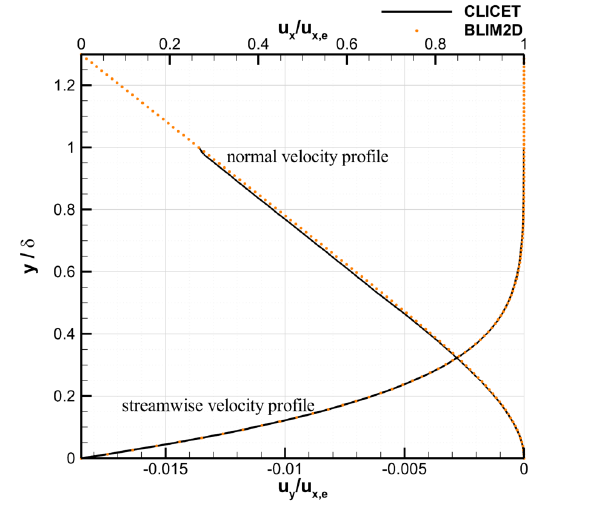
Figure 2. Velocity profiles for CLICET (reference) and BLIM2D, at x / L = 1. Test case 1, N x = 256. For N x = 256 and N = 5, Figure 3a shows that for the first equation of system (22), the heat-flux source term Φ 1 is the only source term that does not vanish. For the second equation (Figure 3b), the dissipation ˙ Q 2 and density R 2 terms still vanish. The same behaviour is observed for the other equations, 3 to N (but it is not shown here for the sake of conciseness). This is consistent with the fact that the test-case running conditions were chosen so that dissipation is negligible and density varies little in order to achieve self-similar temperature profiles. It must be noted that the convective term G 2 is of the same order of magnitude as the heat flux term Φ 2 (although remaining lower). The same behavior is observed for the other equations, 3 to N (however, the source terms become lower for higher number of equations).